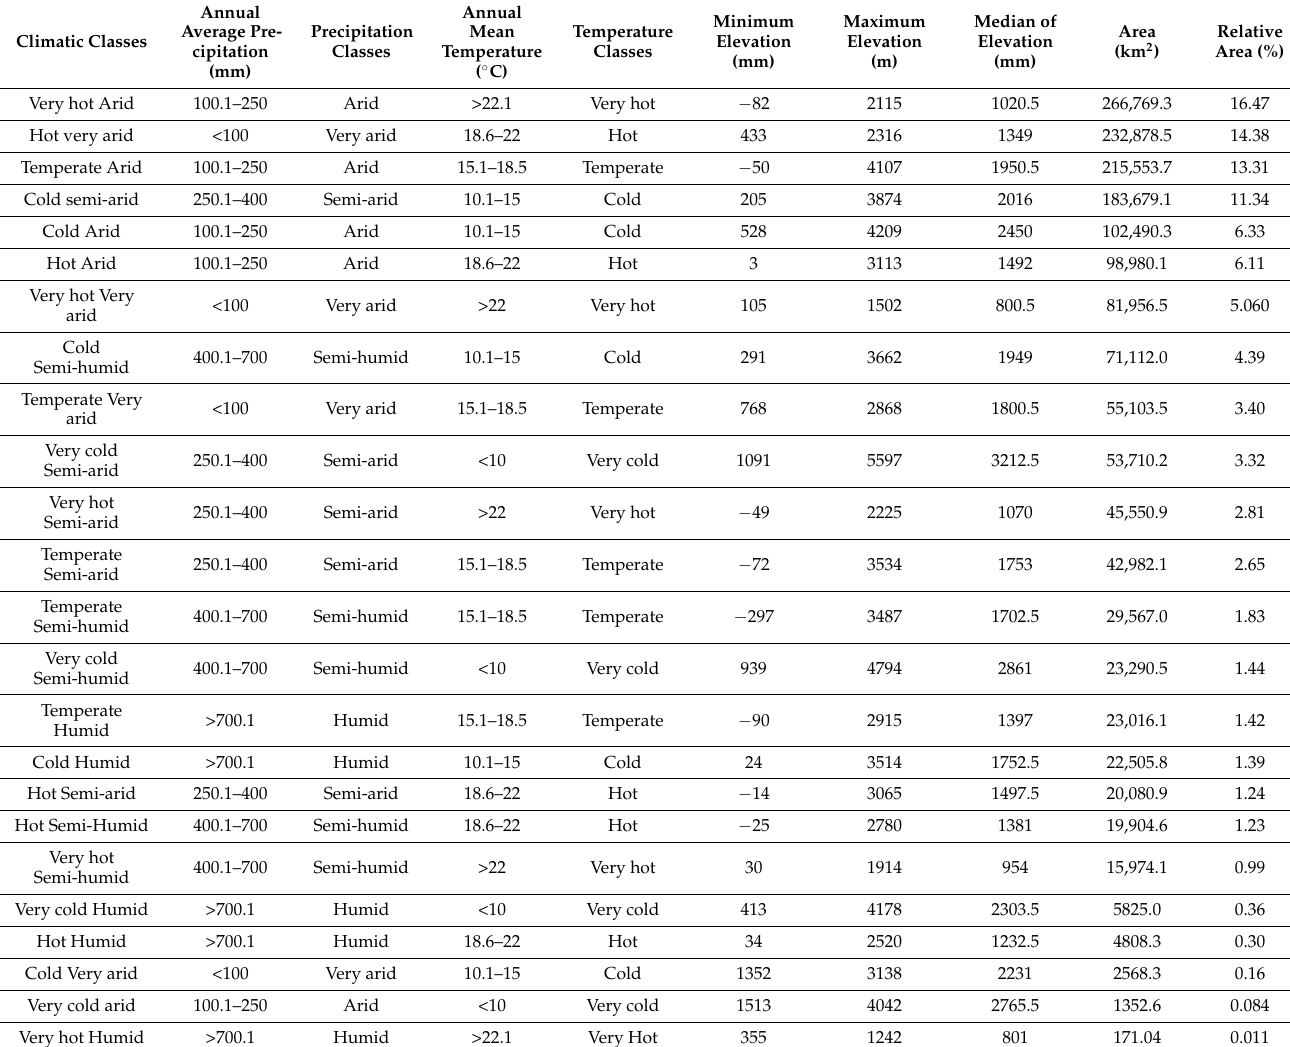
Table 5. Characteristics of Iran’s climatic